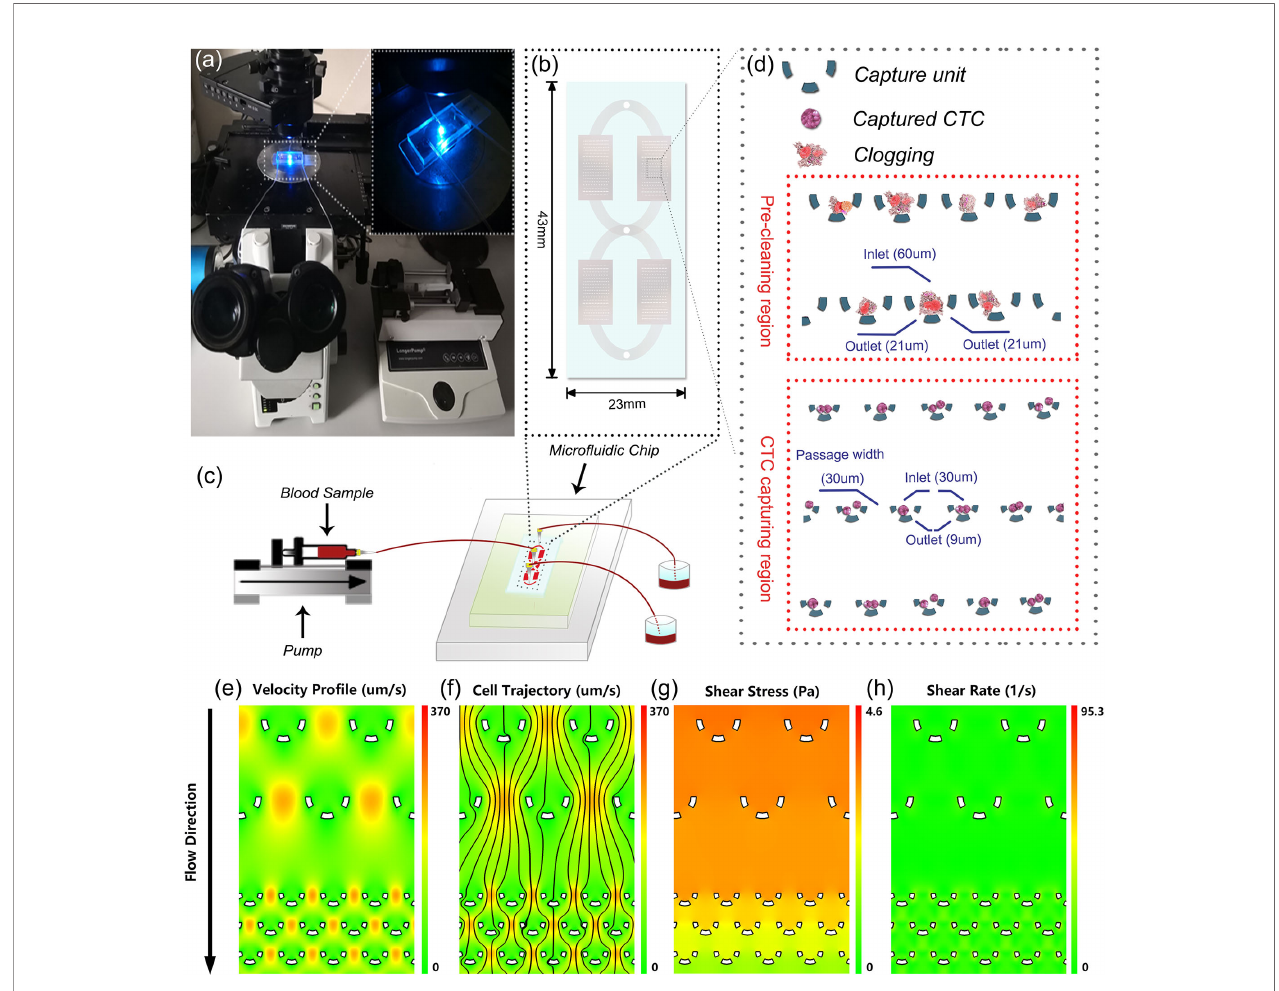
FIGURE 1 | System setup and micro fl uidic chip design. (A) Lab-based setup of the micro fl uidic system. (B) An overview of the micro fl uidic chip. (C) Illustration of the experimental diagram. (D) Detailed design of the micro fl uidic chip. (E – H) Numerical simulation of the hydrodynamics in the micro fl uidic